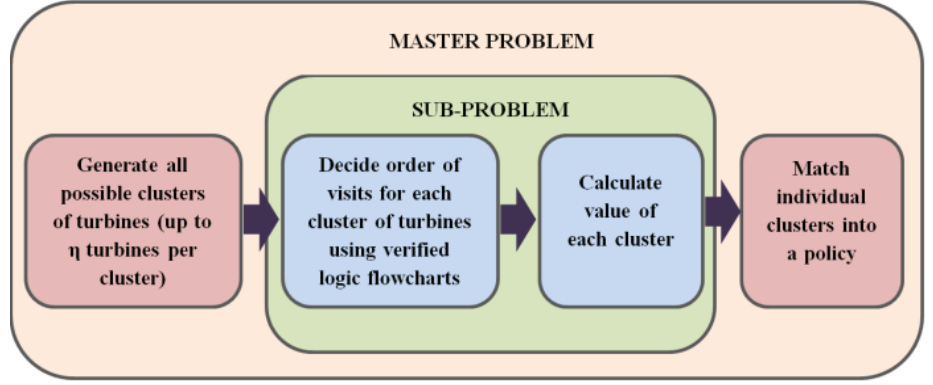
Figure 1. Outline of the model’s structure.